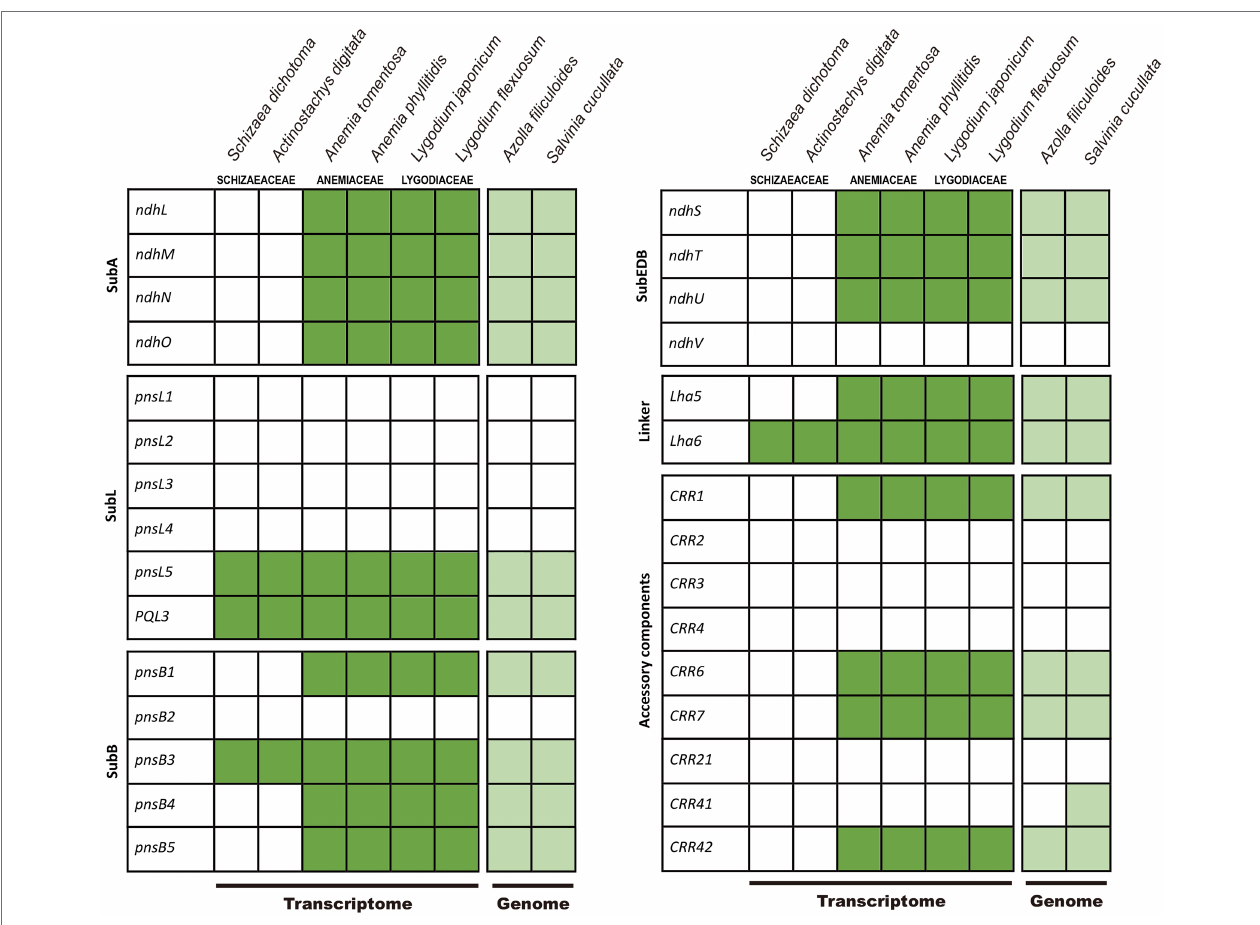
FIGURE 4 | Presence of the nuclear-encoded genes of NADH-like dehydrogenase ( ndh ) complex in Schizaeales transcriptome and fern genomes. The subcomplexes (sub), linker, and accessory components follow the scheme by Shikanai